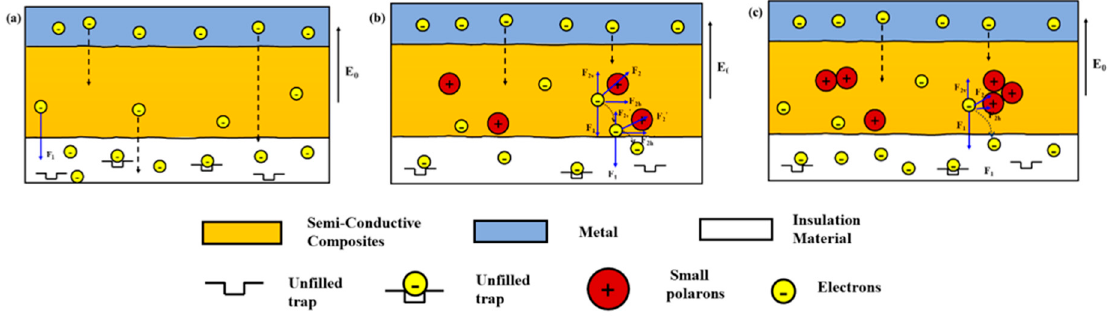
Figure 12. Schematic diagram of the electrons moving path in the semi-conductive layer under the combined action of electric field and the small polarons. ( a ) Without La 0.8 Sr 0.2 MnO 3 ; ( b ) La 0.8 Sr 0.2 MnO 3 content 6 wt %; ( c ) La 0.8 Sr 0.2 MnO 3 content exceed 6 wt %.